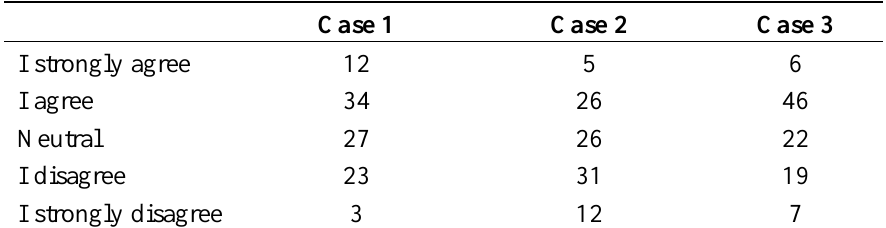
Table 2. Regular work evaluation together with others.